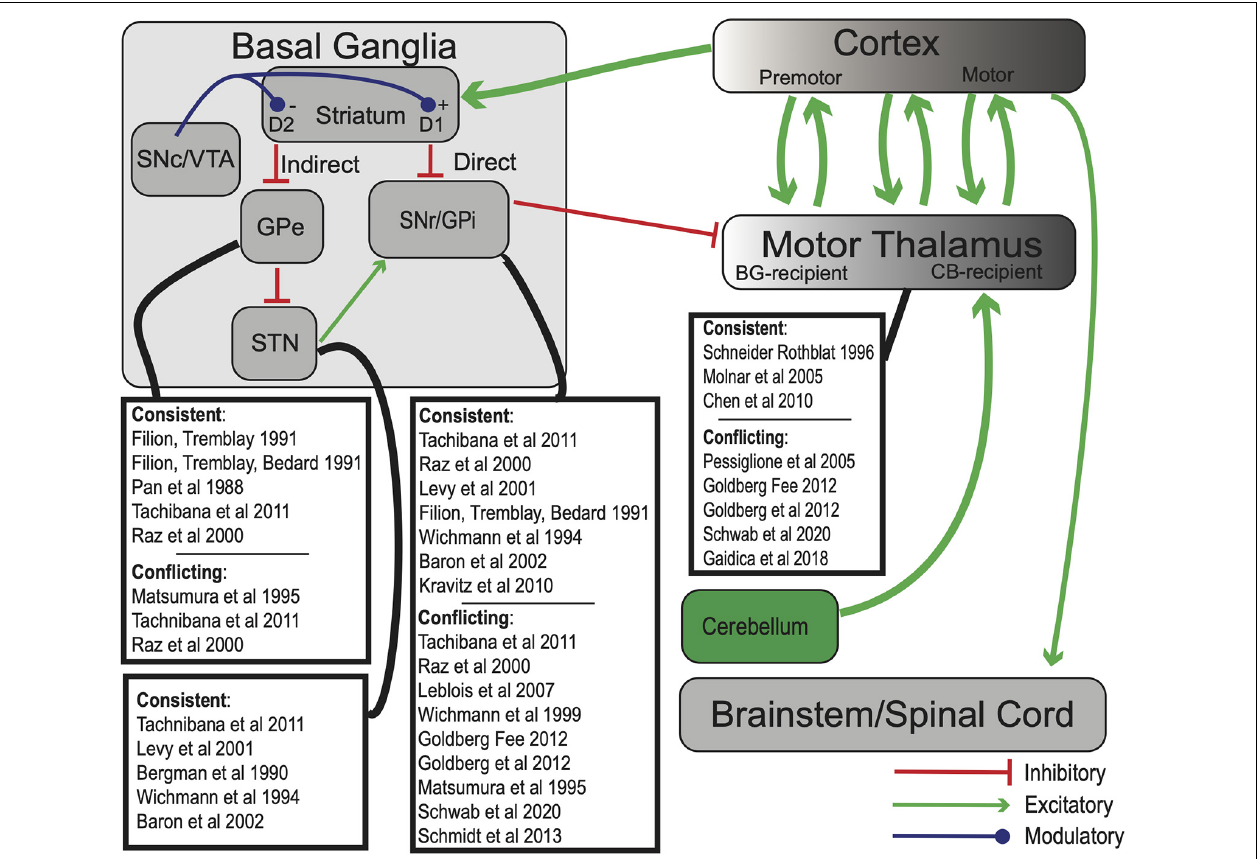
FIGURE 1 | Simplified model of BG-thalamocortical interactions. In standard “rate models” of BG-thalamocortical function, competing direct and indirect pathways determine SNr/GPi firing rates, which in turn suppress or release BG-recipient motor thalamic regions to drive movement. Green arrows—excitatory (glutamatergic) projections; red—inhibitory (GABAergic) projections, blue—dopaminergic. Experiments whose results are consistent or conflict with rate model predictions are highlighted for each BG nucleus. Note that some experiments may have results that both support and contradict the rate model, even in the same nucleus. Abbreviations are defined in the